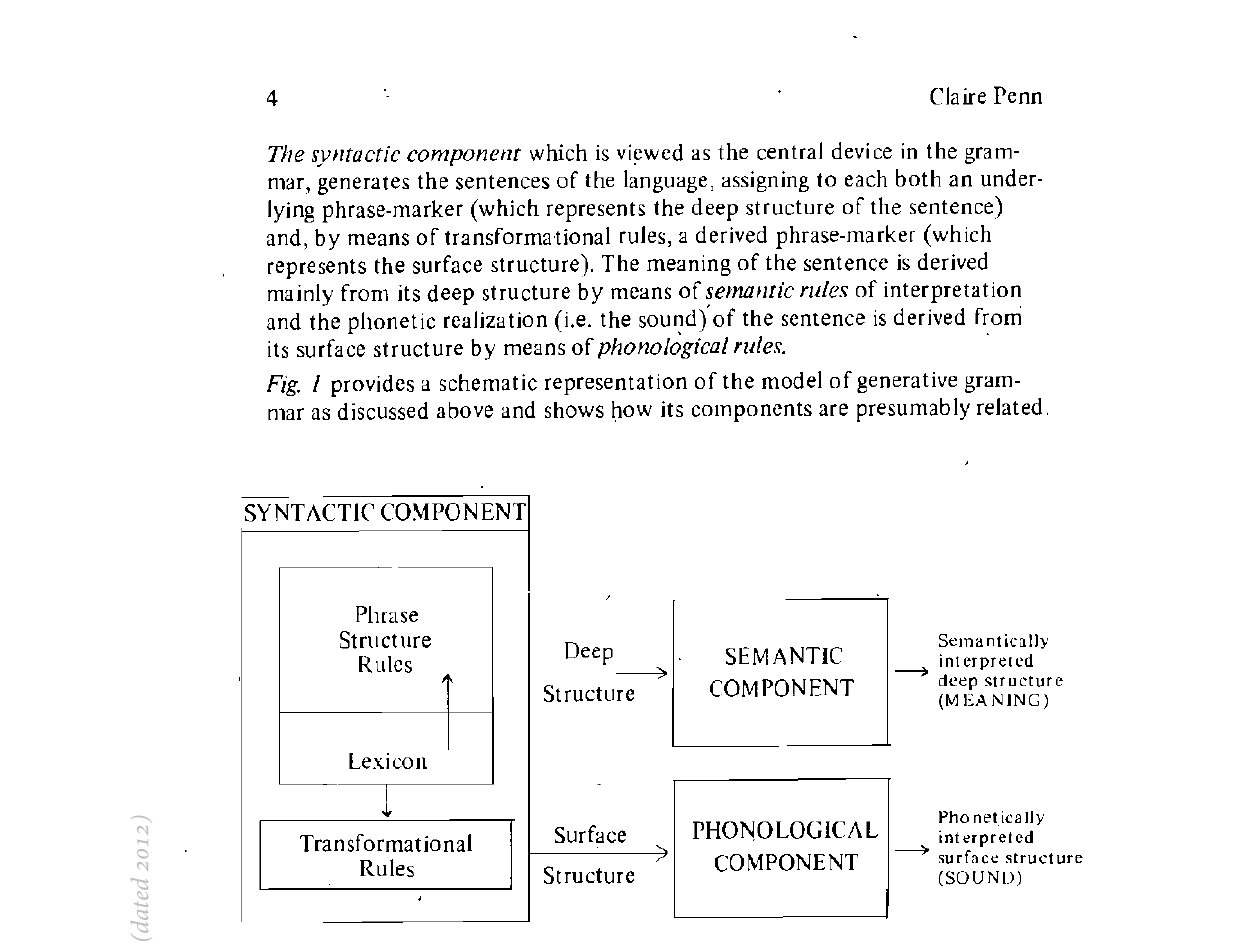
Fig. 1. The Components of a Linguistic Description (adapted from Fodor et al. 4